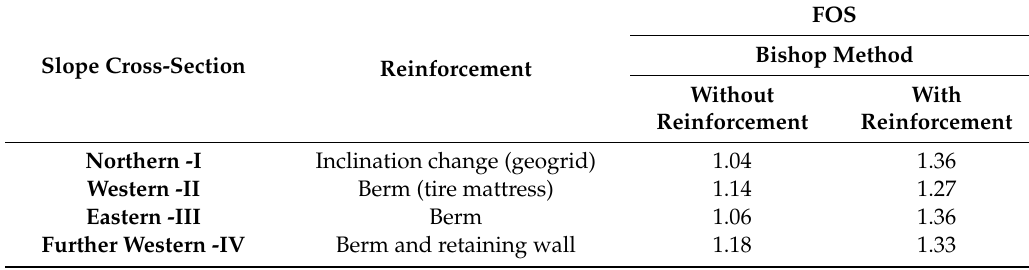
FOS Bishop Method Without With Reinforcement Reinforcement